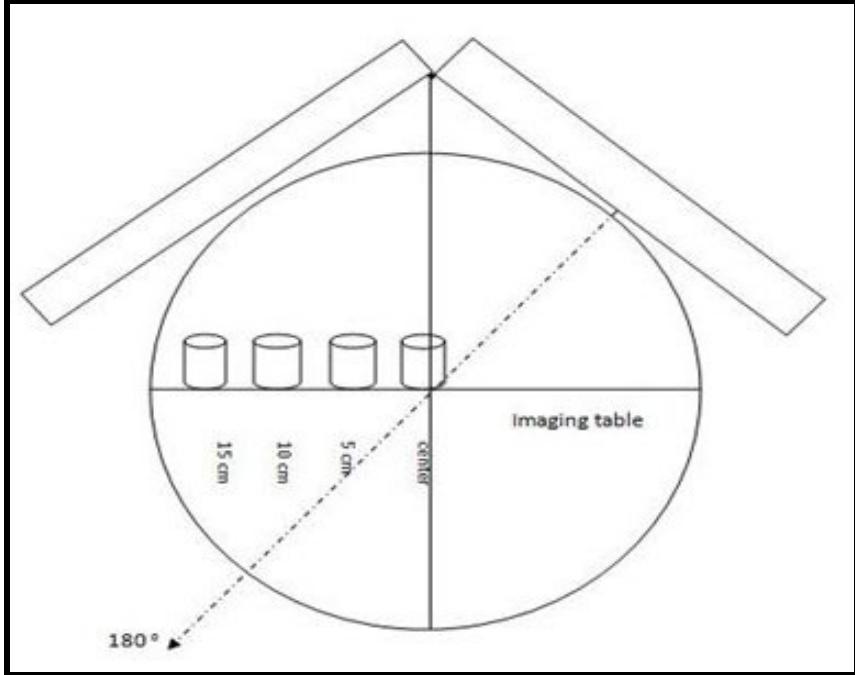
Figure 2. Schematic of four myocardial phantom positions on an imaging table.